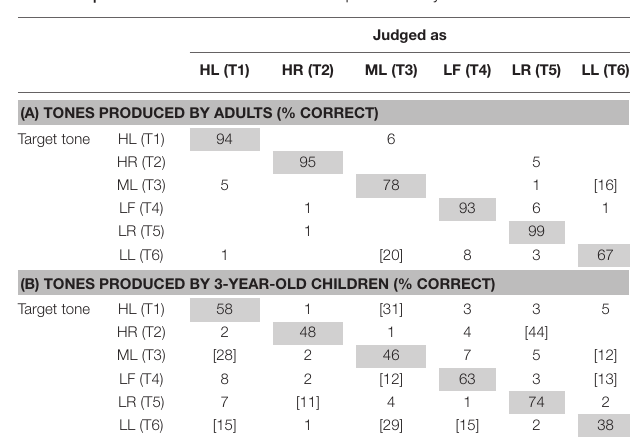
TABLE 4 | Confusion matrices of the tones produced by adults and children.